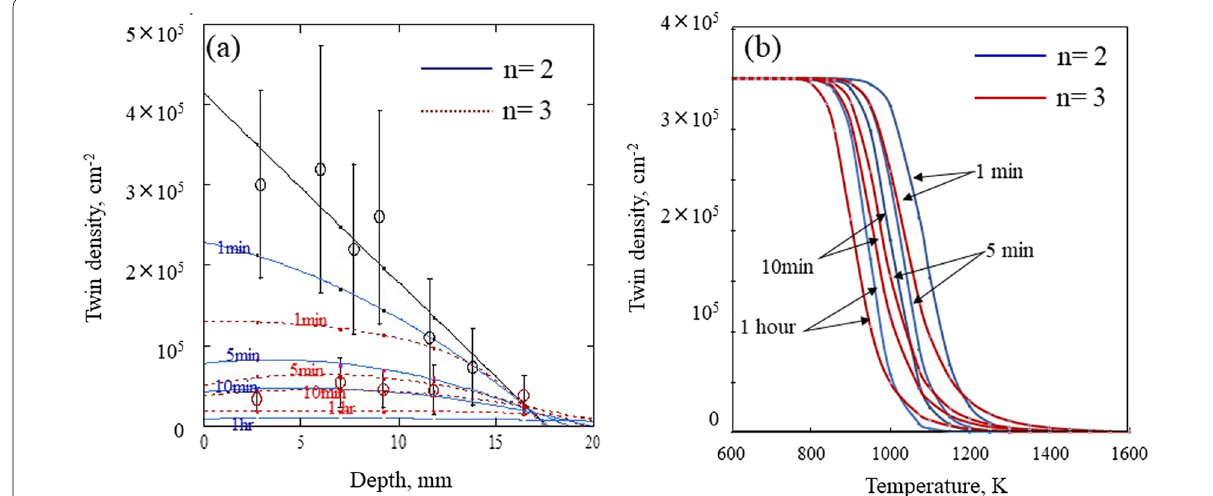
Fig. 13 The effect of time ( a ) and temperature ( b ) for annealing of twins assuming n 2 and 3 for decreasing rate expressed by an empirical n-th = order recrystallization kinetics expression, d ρ /dt kρ n , where k is the rate constant for recrystallization (see the text for more details). a Decrease = − in twin density by annealing during time intervals from one minute to one hour at 1070 K and various depths of the sample for n 2 (blue curves) = and for n 3 (red dotted curves). The experimental data for Run 011 and Run 011H (10-min annealing at 1070 K) are shown as black open and red = open circles, respectively. b The change in twin density by annealing at various temperatures and durations from one minute to one hour for n 2 = (blue curves) and n 3 (red curves). The initial twin density before annealing was taken as 3.5 10 5 cm − 2 , and the activation energy E a of 250 kJ/ = × mol was adopted for the recrystallization process of